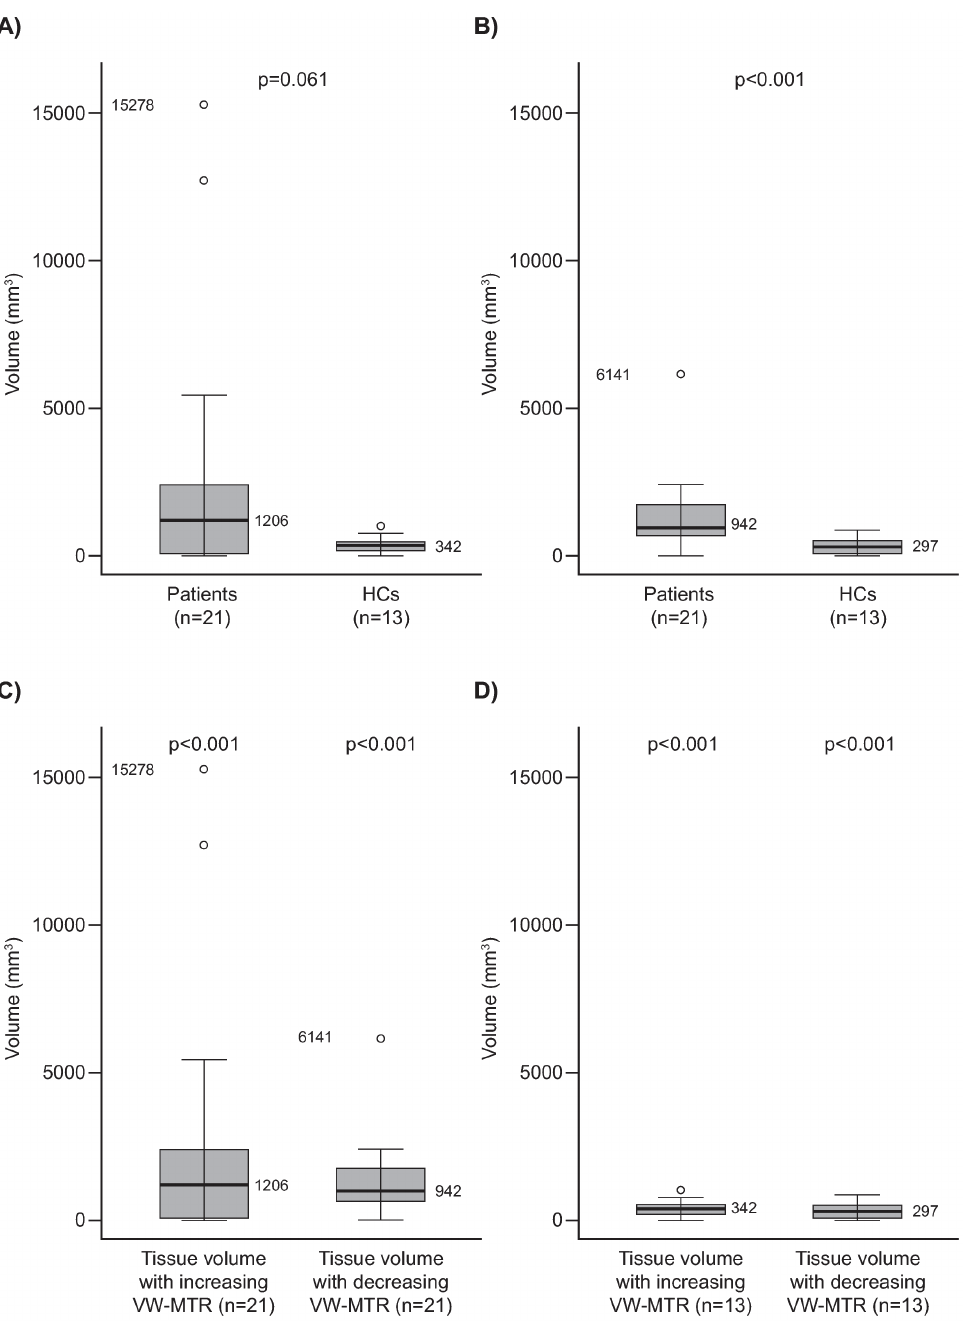
Figure 2. Change in VW-MTR in NABT from baseline to 24 weeks. The figure depicts a comparison between patients and HCs with A) increasing VW-MTR and B) decreasing VW-MTR and difference from baseline within each study group for increasing and decreasing VW-MTR in C) patients and D) HCs. For A) and B), the p value is the difference between patients and HCs from the Wilcoxon rank–sum test; for C) and D), the p-value is the difference from baseline within groups from the Wilcoxon signed–rank test. In the box plots, the bold line represents the median; the boxes represent the middle 50% of data; the top and bottom of the box represent the third and first quartiles; the open circles are outliers. The whisker lines above and below the boxes represent the largest and smallest values that are not considered to be outliers. HC, healthy control; NABT, normal appearing brain tissue; VW-MTR, voxel-wise magnetization transfer ratio.